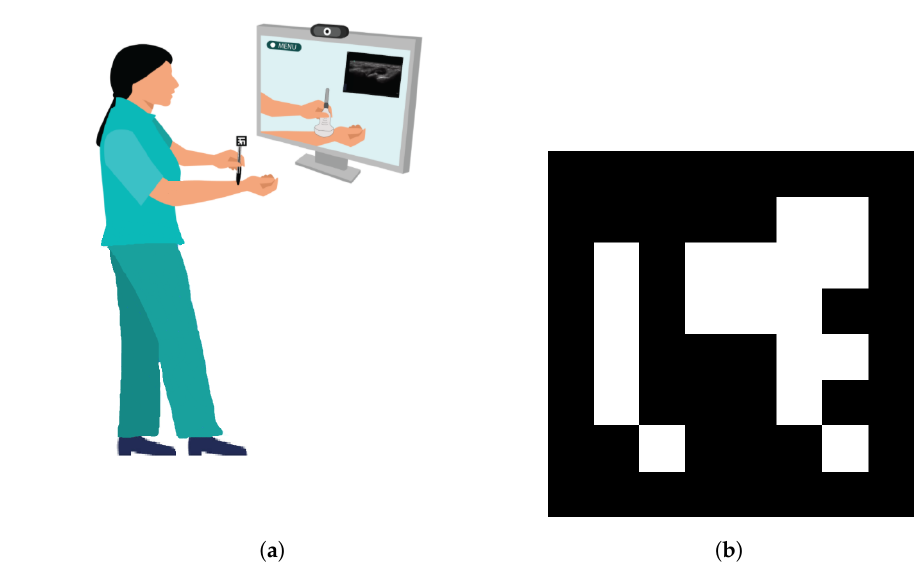
Figure 1. Ultrasound training system ( a ) using the ArUco marker ( b